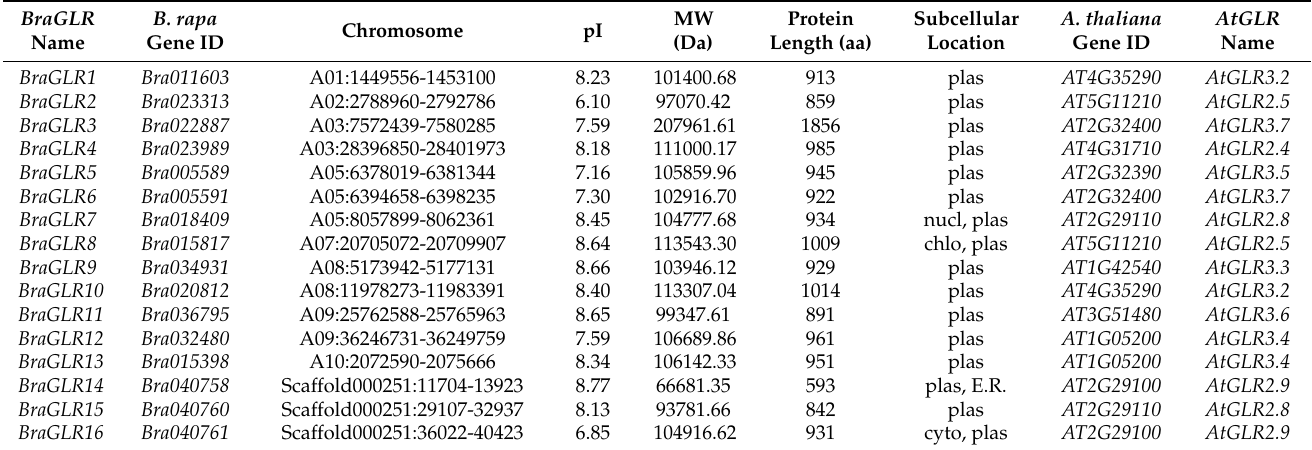
Table 1. Information about GLR gene family members of B. rapa